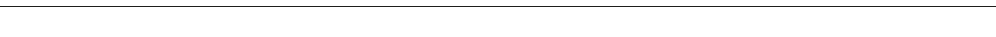
Fig. 5 Hematological and immunological analyses. a – j Number and size of the different blood cell types were determined using a hematology analyzer (two-way ANOVA; young + AL: n = 16, young + EOD: n = 16, old + AL: n = 20, old + EOD: n = 22). a RBC count, b hemoglobin concentration, c HCT, d MCHC, e RDW, f platelet count, g platelet volume, h PDW, i large cell ratio of platelets ( > 12 fl ), and j PCT. k – w Peripheral blood leukocytes were analyzed using a ten-color fl ow cytometer (two-way ANOVA; young + AL: n = 16, young + EOD: n = 16, old + AL: n = 20, old + EOD: n = 22). Only CD45- positive cells were included in the analysis. k T cells (CD3 + CD5 + ), l Ly6C + T cells, m B2 cells (CD5 − CD19 + B220 + ), n CD11b + B cells (CD19 + B220 + ), o Ly6C + B cells (CD19 + B220 + ), p natural killer (NK) cells (CD3 − CD5 − NKp46 + and/or NK1.1 + ), q CD11b + NK cells, r CD11c + NK cells, s NKT cells (CD3 + CD5 + NKp46 + and/or NK1.1 + ), t granulocytes (CD11b + Ly6G + ), u Ly6C + monocytes (CD11b + ), v Ly6C − monocytes (CD11b + ), w non-speci fi c cells, x